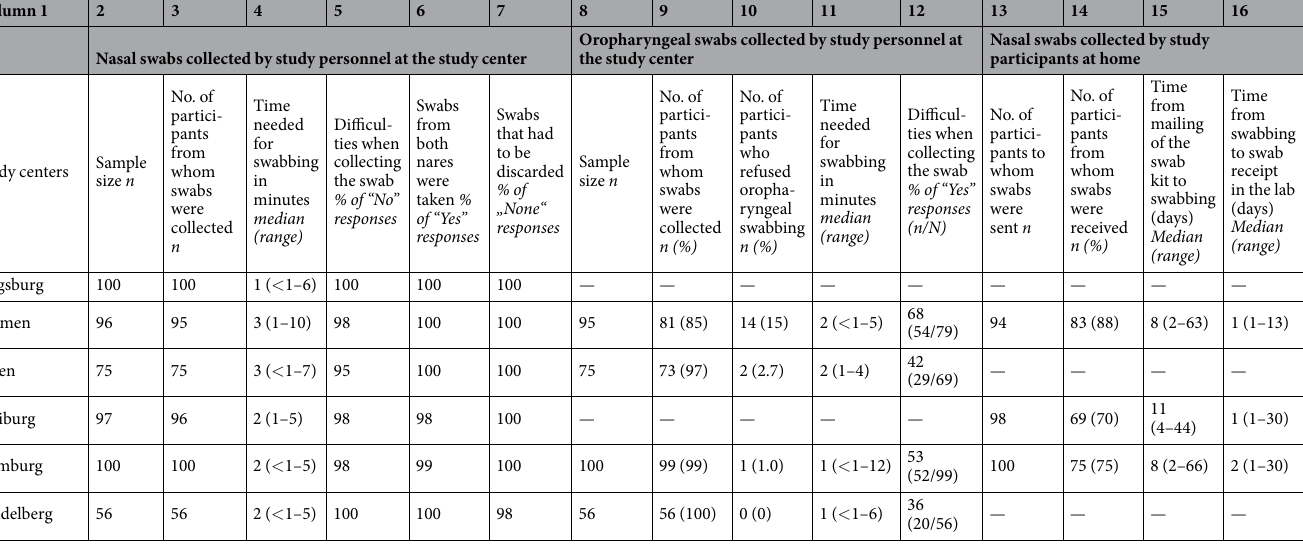
Table 1. Selected feasibility aspects of nasal and oropharyngeal swabbing.